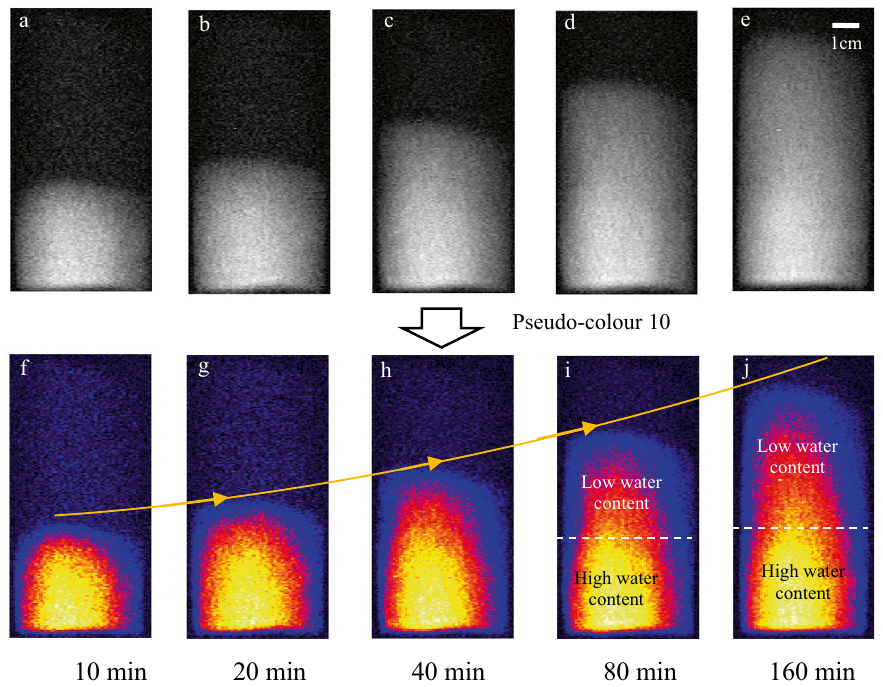
Figure 2. Liquid capillary rise characteristics with time.